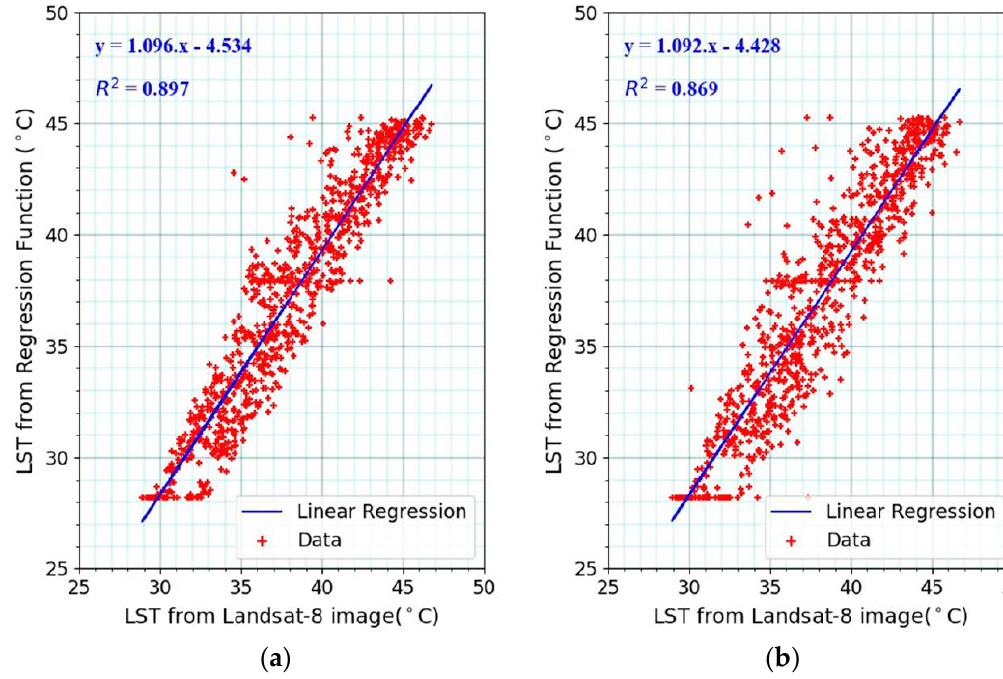
Figure 10. Land-use composition-driven predictions of LST for the hottest day of 2016 (1 June) versus LST observed by Landsat-8 for ( a ) 510 × 510 m and ( b ) 330 × 330 m window sizes.